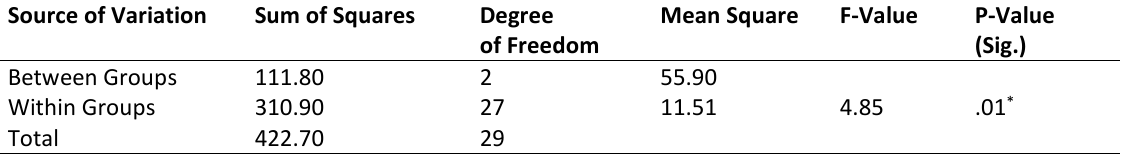
Table 12. One way analysis of variance (Anova) results among judo, taekwondo and boxing players with regard to the sub-parameter team ritual Source of